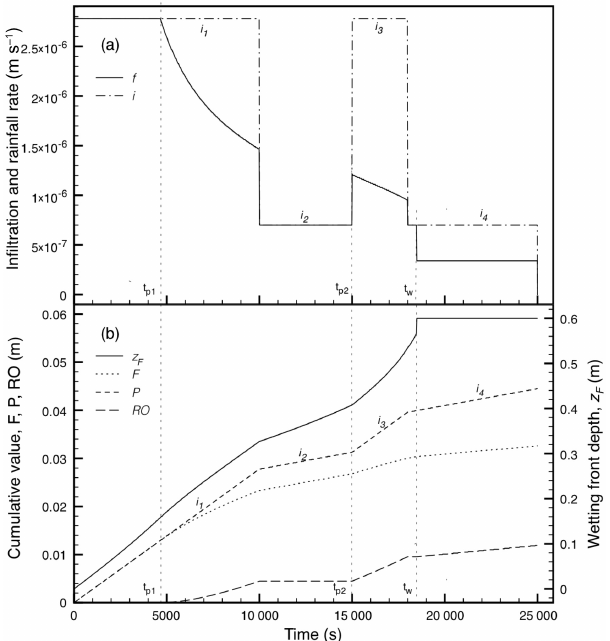
Figure 7. Simulation of an unsteady rainfall event on the clay soil in initial equilibrium with a shallow water table at 150cm depth, nonponded conditions, and vertical drainage (Vachaud) bot- tom boundary conditions ( f w ) : (a) infiltration ( f ) and rainfall rates ( i , subindices in i 1 to i 4 represent the rainfall periods within the hyetograph); (b) cumulative rainfall ( P) , infiltration ( F) , excess runoff (RO), and wetting front depth ( z F ) during the